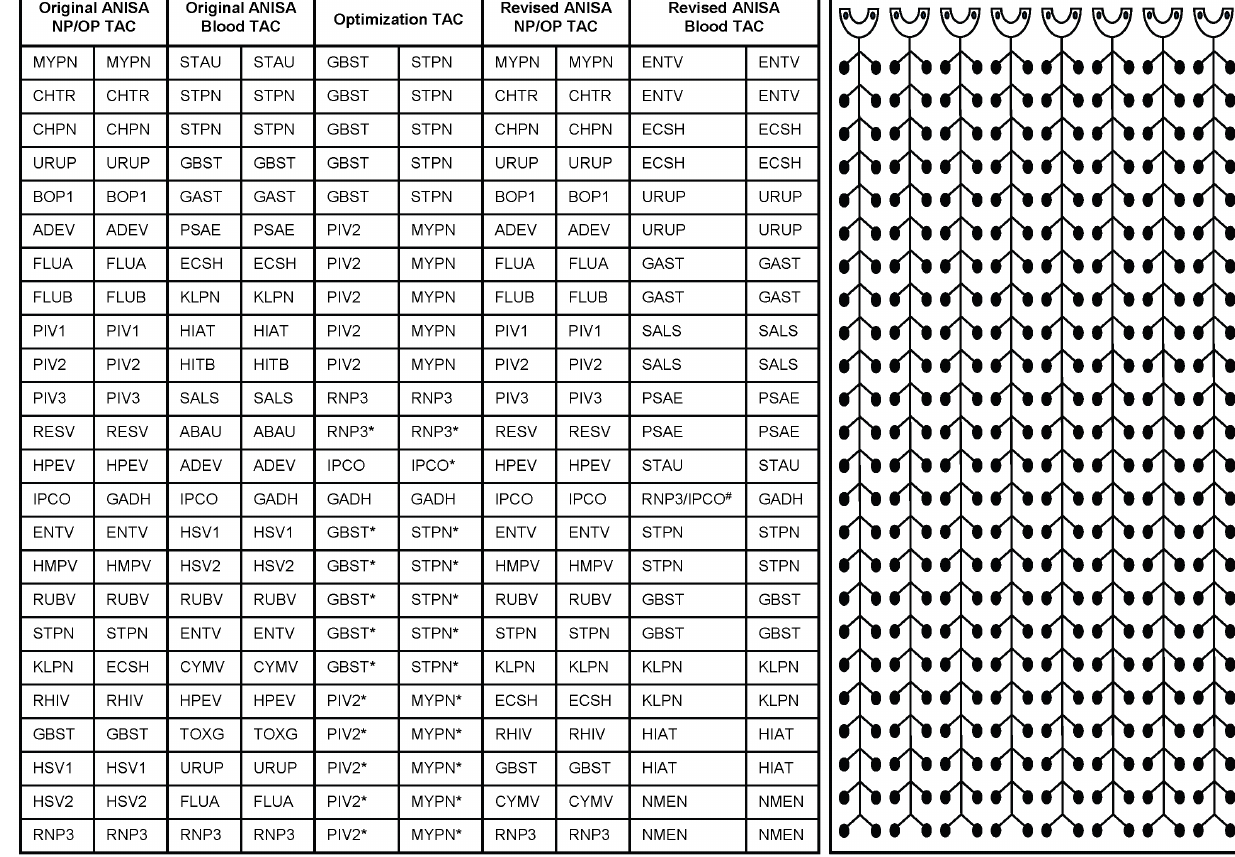
Figure 1. ANISA-specific TAC configurations. Original ANISA NP/OP TAC, Original ANISA Blood TAC, Optimization TAC, Revised ANISA NP/OP TAC, Revised ANISA Blood TAC. Target designations include: MYPN, Mycoplasma pneumoniae ; CHTR, Chlamydia trachomatis ; CHPN, Chlamydophila pneumoniae ; URUP, Ureaplasma spp.; BOP1, Bordetella pertussis ; ADEV, Adenovirus; FLUA, Influenza A; FLUB, Influenza B; PIV1, Parainfluenza virus 1; PIV2, Parainfluenza virus 2; PIV3, Parainfluenza virus 3; RESV, Respiratory Syncytial Virus; HPEV, Human Parechovirus; IPCO, Internal Positive Control; GADH, Glyceraldehyde phosphate dehydrogenase (Manufacturing control); ENTV, Enterovirus; HMPV, Human Metapneumovirus; RUBV, Rubella virus; STPN, Streptococcus pneumoniae ; KLPN, Klebsiella pneumoniae ; ECSH, Escherichia coli / Shigella spp.; RHIV, Rhinovirus; GBST, Group B Streptococcus ; HSV1, Herpes Simplex Virus 1; HSV2, Herpes Simplex Virus 2; RNP3, Human RNaseP; STAU, Staphylococcus aureus ; GAST, Group A Streptococcus ; PSAE, Pseudomonas aeruginosa ; HIAT, Haemophilus influenzae ; HITB, Haemophilus influenzae type B; SALS, Salmonella spp.; ABAU, Acinetobacter baumannii ; CYMV, Cytomegalovirus; TOXG, Toxoplasma gondii ; NMEN, Neisseria meningitidis . All oligonucleotides were spotted at 1 6 final concentration except where noted by * where concentration is 2 6 . # Duplex assay consisting of RNP3 assay with FAM-labeled probe and IPCO assay with VIC-labeled probe.